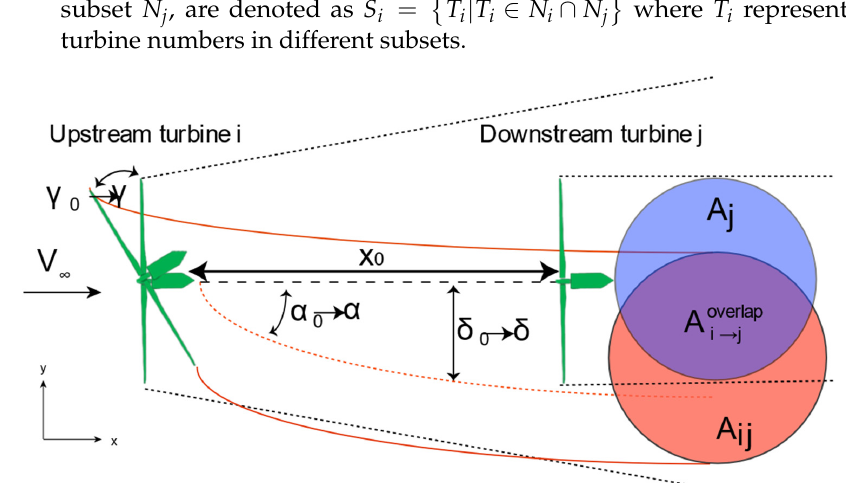
Figure 2. An example of a two-turbine wake redirection control through setting the yaw misalignment angle. γ is the upstream turbine i ’s yaw angle, α is the deflection angle, and δ denotes the wake deflection. The black dashed lines represent the wake of the upstream turbine i with no yaw control, and the red lines indicate the wake of the upstream turbine i with yaw control. A overlap the area overlap ratio that the wake effect area A ( Ti | Tj ) of the upstream turbine i to the downstream turbine j and the rotor area A ( Tj ) of downstream turbine j